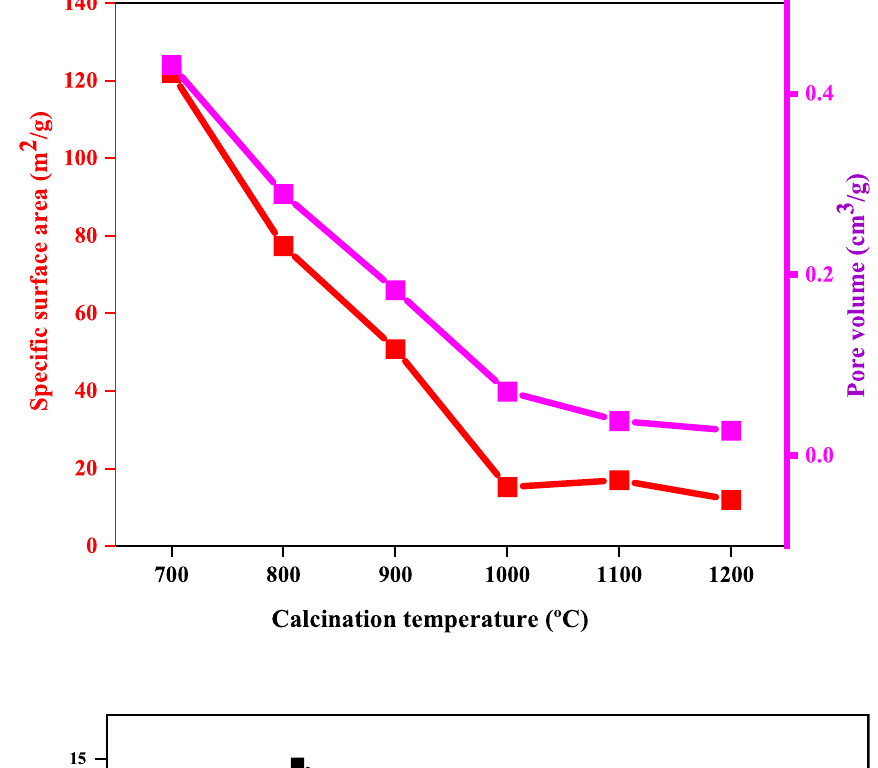
Fig. 10 Effect of calcination temperatures upon average pore diameter of BeO nanofib-